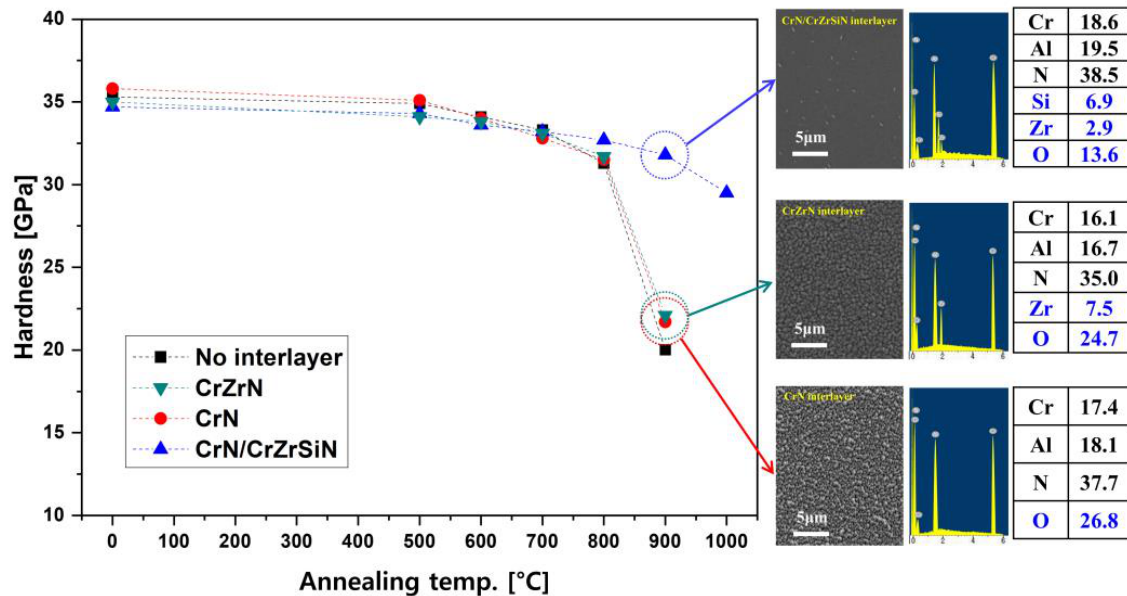
Figure 5. Hardness variation in the CrAlN coatings with three interlayers after annealing test in air for 30 min, and the surface EDS data of each coating after annealing.